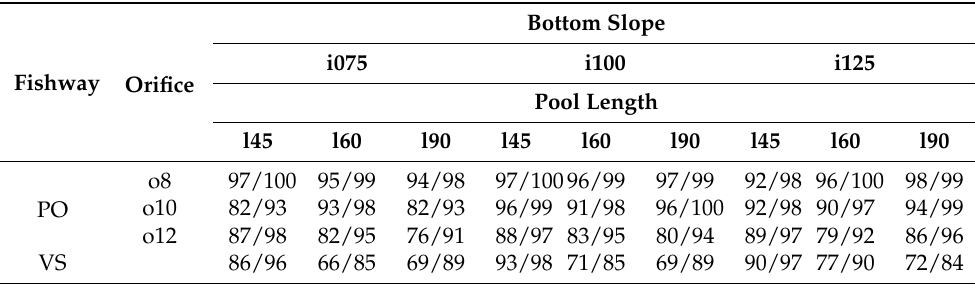
Table 2. Fraction (%) of the Reynold’s shear stress values below disorientation/injury boundary in the recirculation